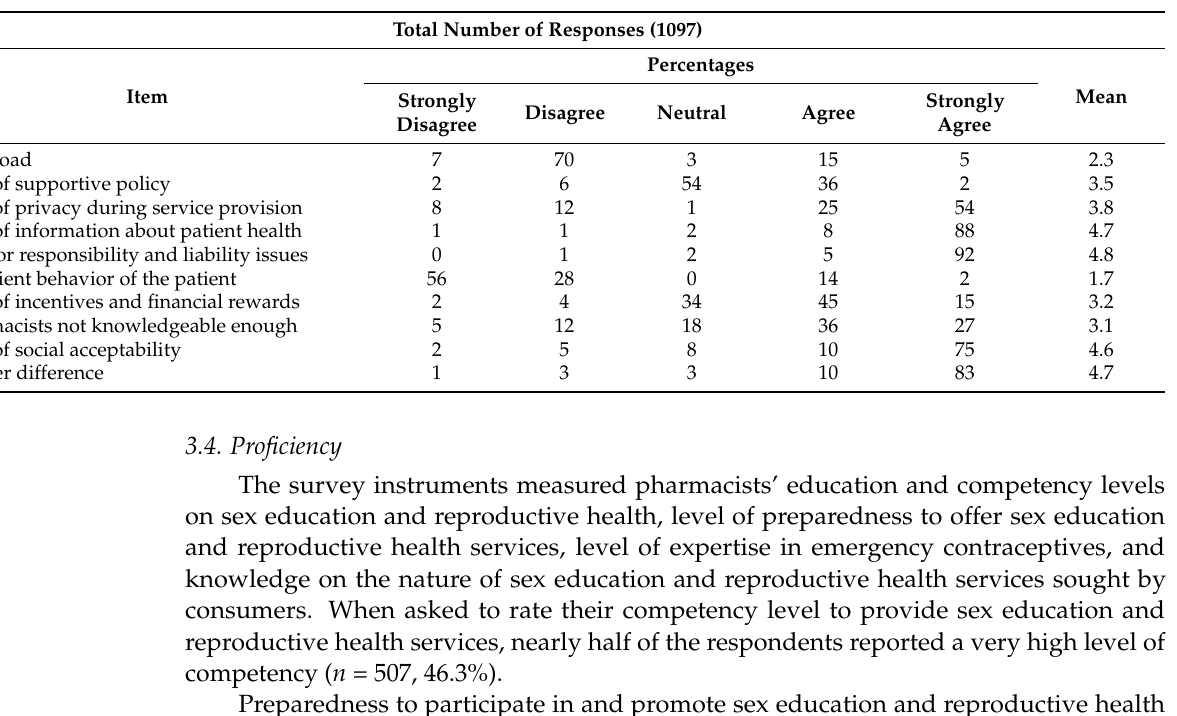
Table 2. Barriers to offering sexual and reproductive health services among community